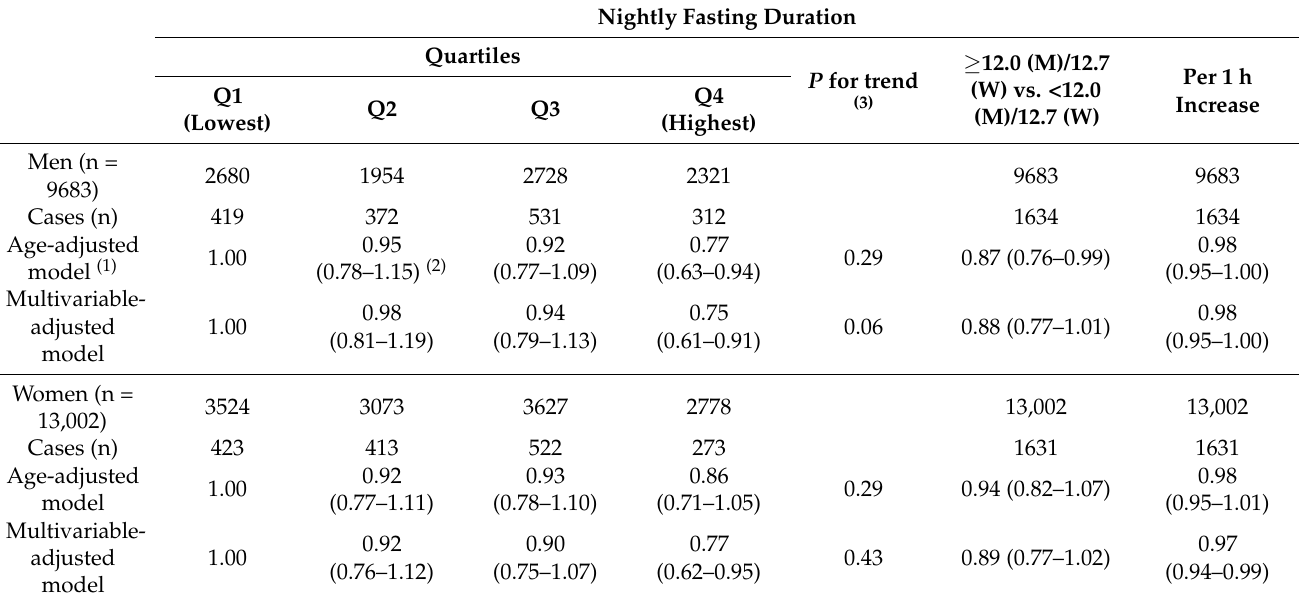
Table 4. Adjusted odds ratios and 95% confidence intervals of type 2 diabetes mellitus based on quartiles, median, and continuous types of nightly fasting duration in Korean